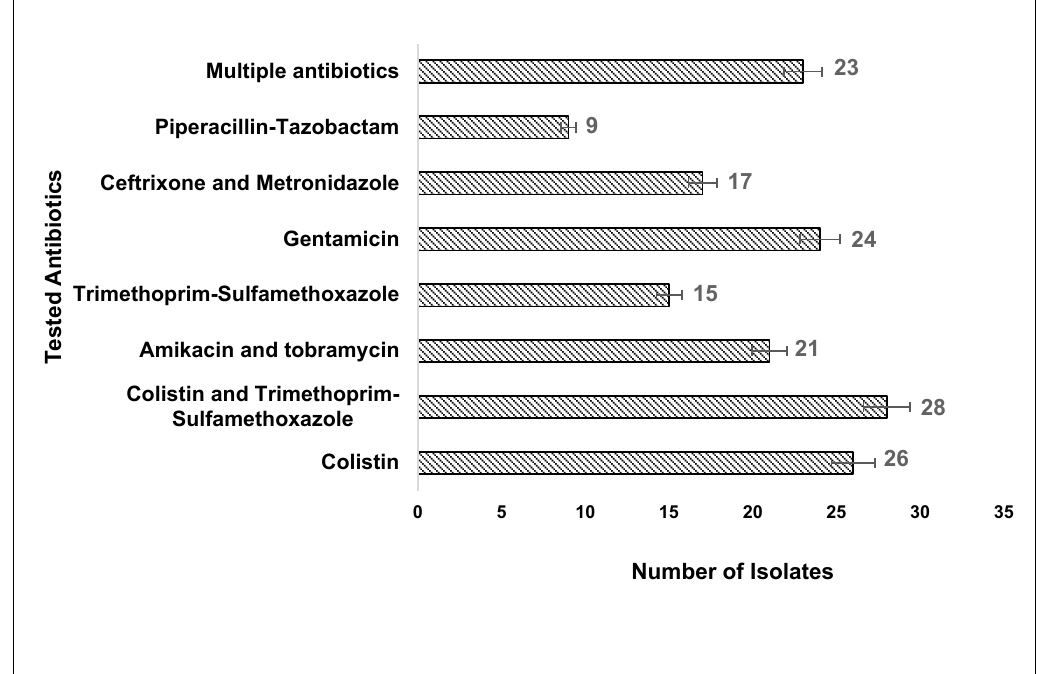
Figure 1. The number of A. baumannii isolates susceptible to the tested antibiotics.